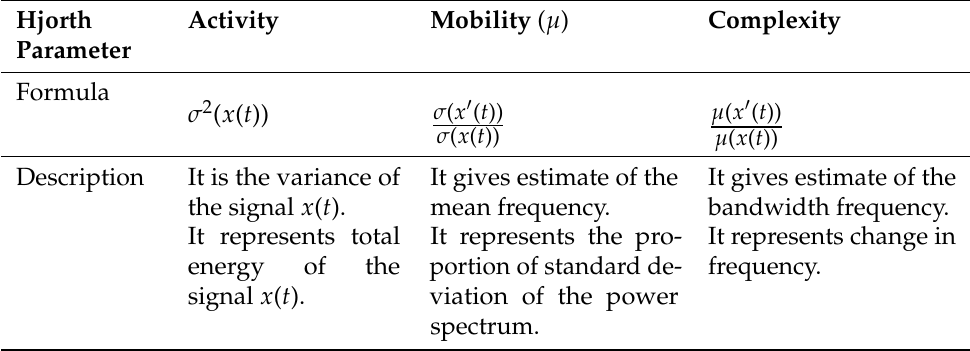
Table 2. Details about Hjorth parameters used in this study [51].